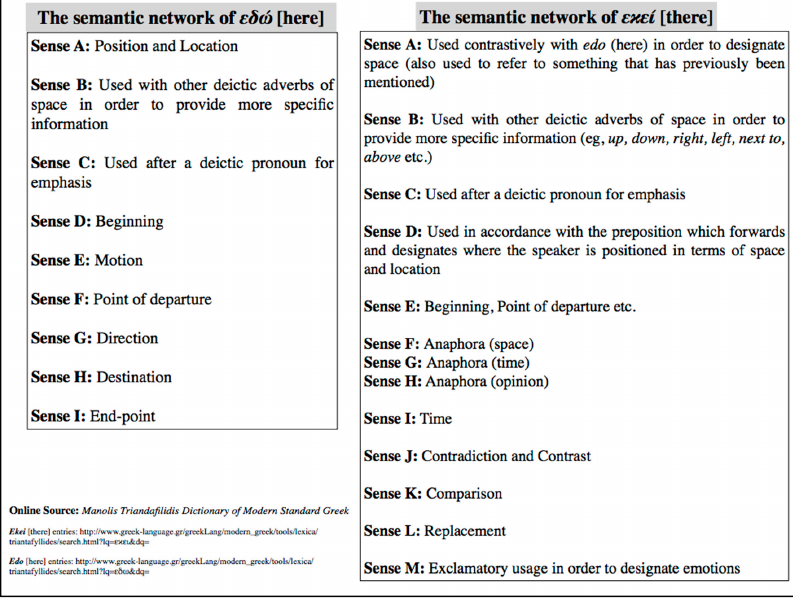
Figure 4. The semantic networks of the Greek deictic adverbs εδώ [here] and εκεί [there].